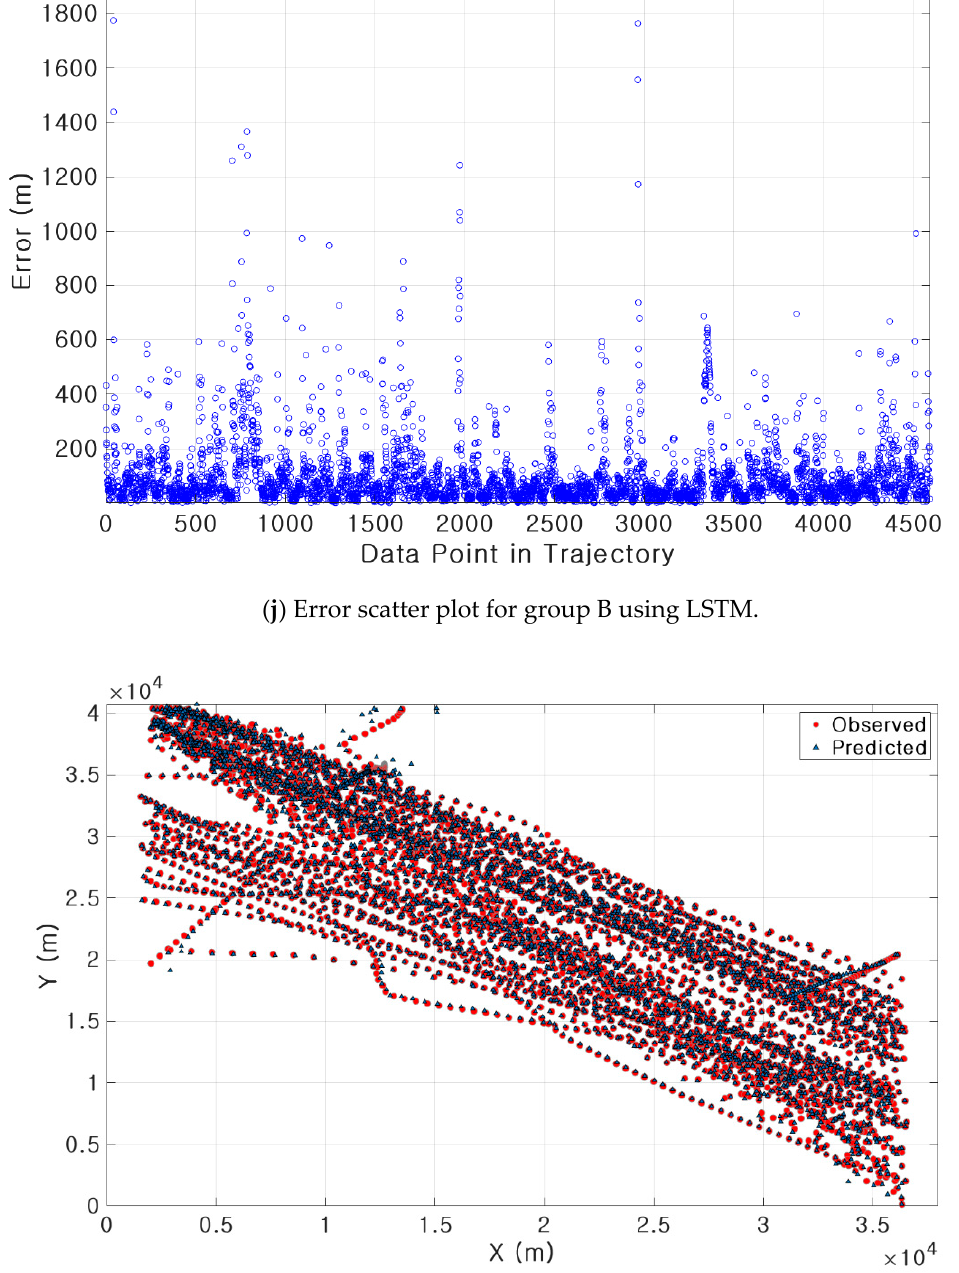
( k ) Predicted trajectory for group B using GRU. Figure 8.